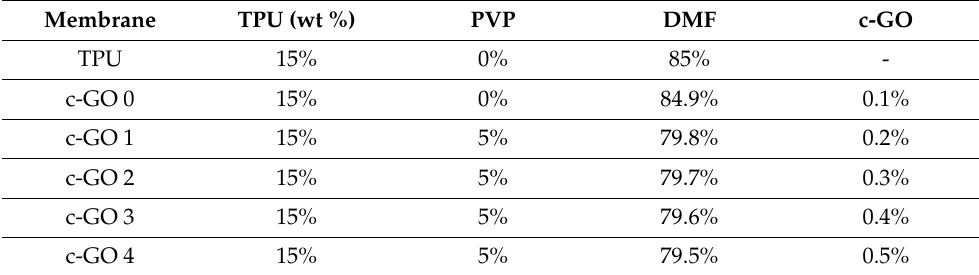
Table 1. Compositions of c-GO based TPU